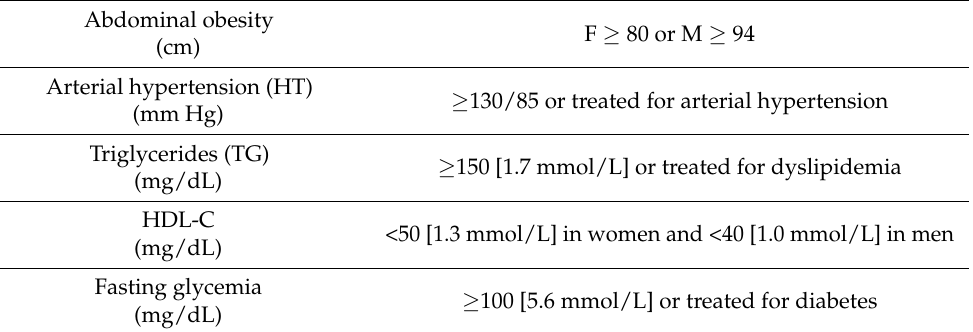
Table 1. IDF criteria of metabolic